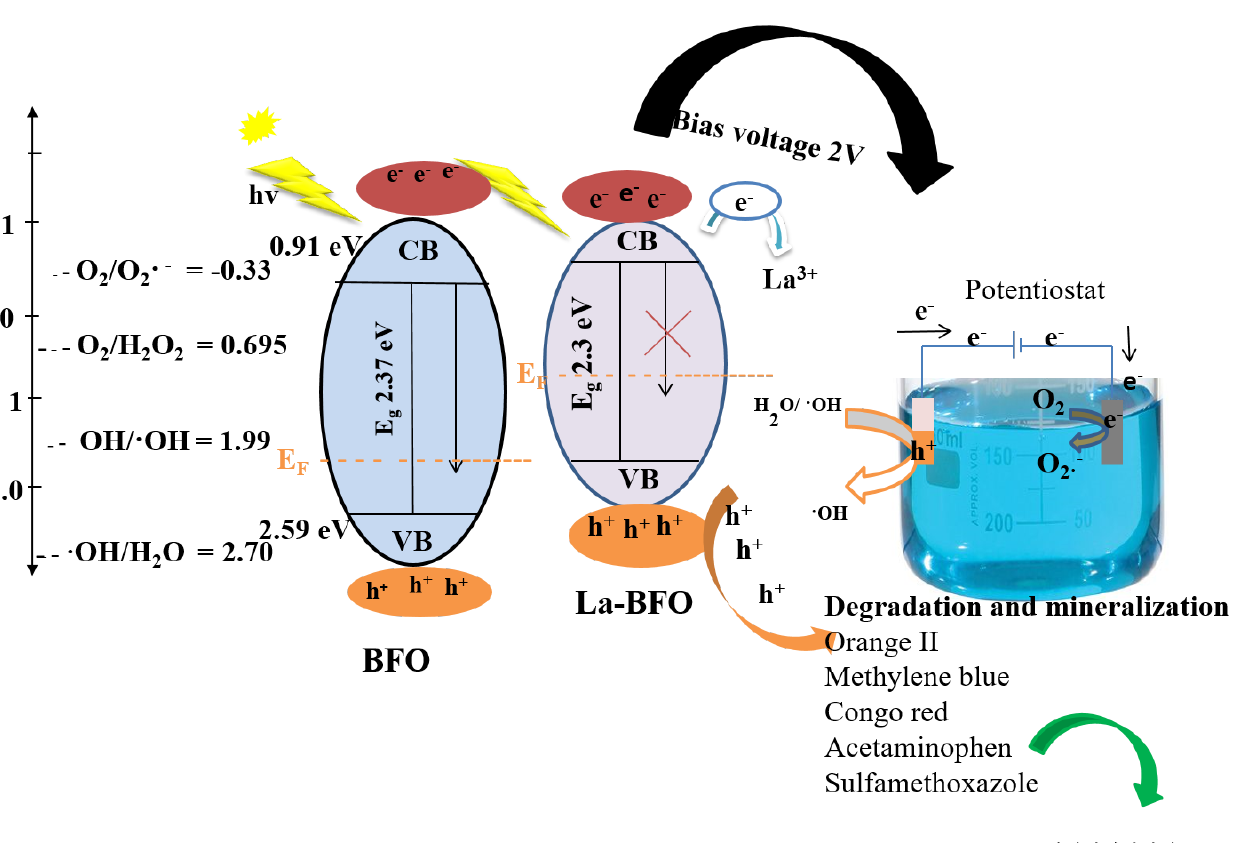
Figure 5. Schematic representation of the proposed mechanism of the photoelectrocatalysis of BFO and 10% La-BFO for the degradation of emerging pollutants.